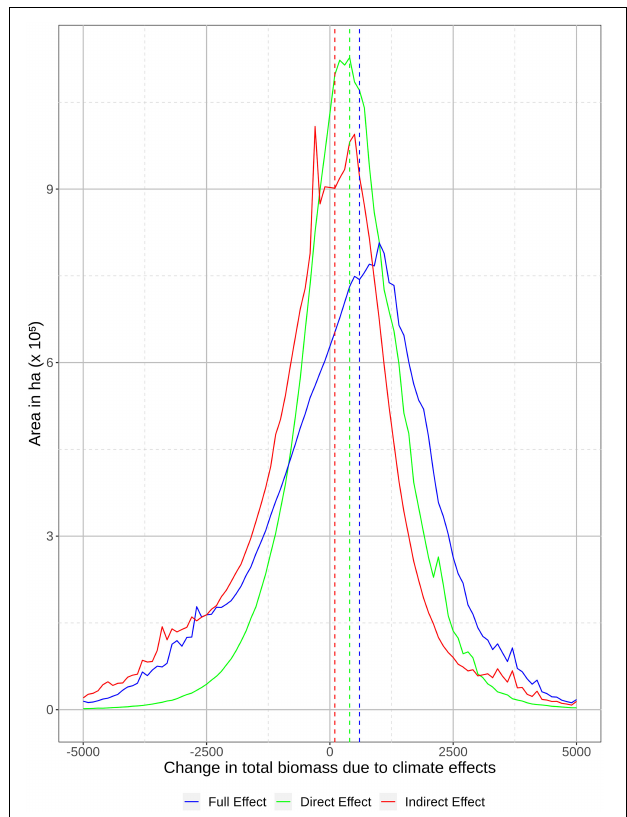
FIGURE 4 | Distribution of area (number of pixels multiplied by resolution) difference of simulated tree species biomass (kg/ha) across models and replicates within the study area in 2100. Dashed lines represent median of biomass differences due to direct climate effects on vegetation (+400 kg/ha; green), indirect effects via fire (+100 kg/ha; red), and the total net effects (+600 kg/ha; blue).